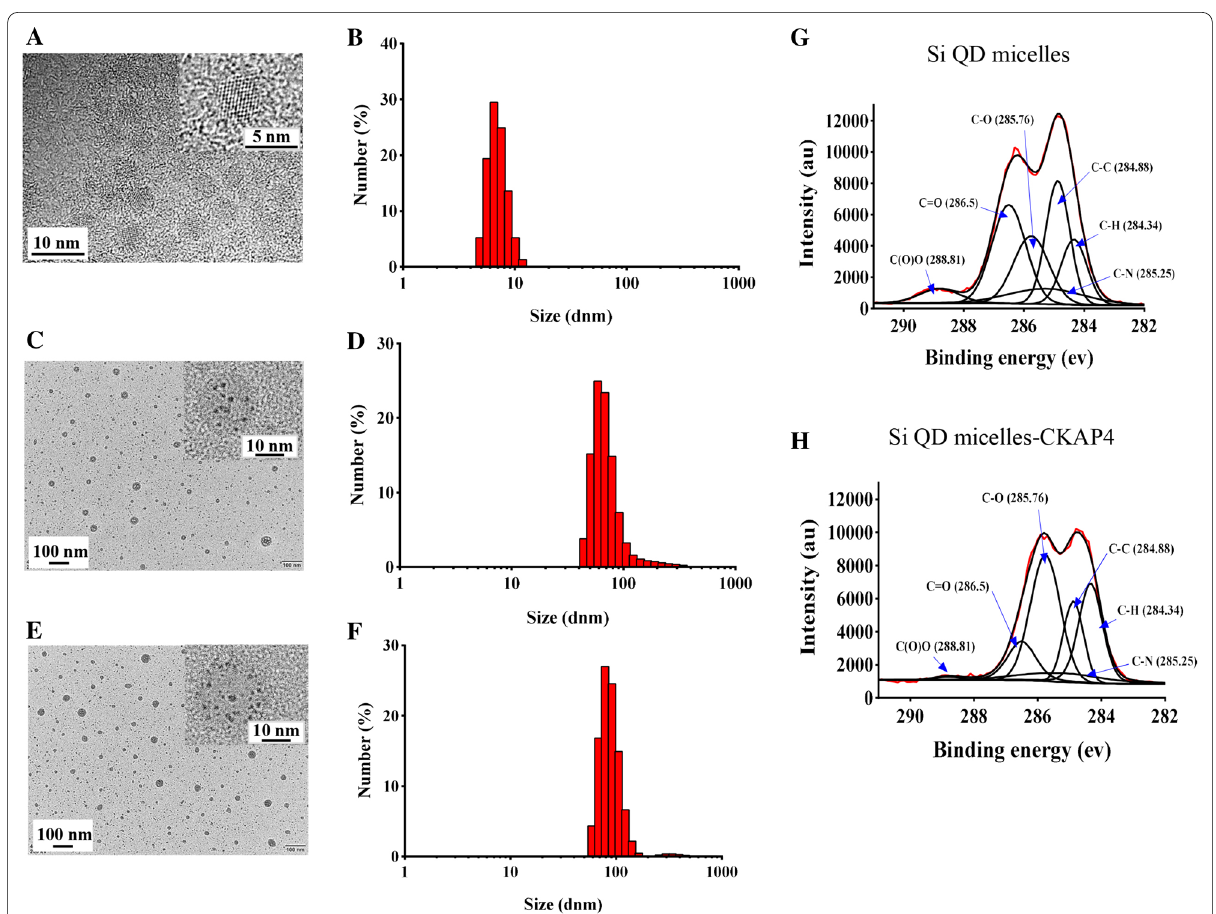
Fig. 1 a TEM images of dodecyl-Si QDs; b hydrodiameter distribution of dodecyl-Si QDs; c TEM images of Si QD micelles; d hydrodiameter distribution of Si QD micelles; e TEM images of Si QD micelles-CKAP4; f hydrodiameter distribution of Si QD micelles-CKAP4; g C1s X-ray photoelectron spectroscopy (XPS) spectra of Si QD micelles; h C1s XPS spectra of Si QD